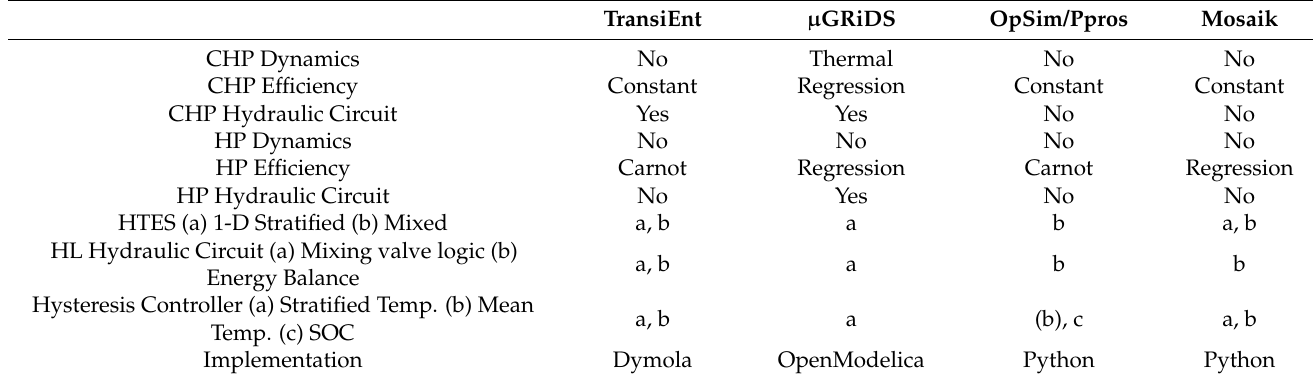
Table 4. Main characteristics of the models used for the simulation of CHP and HP scenario. TransiEnt µ GRiDS OpSim/Ppros